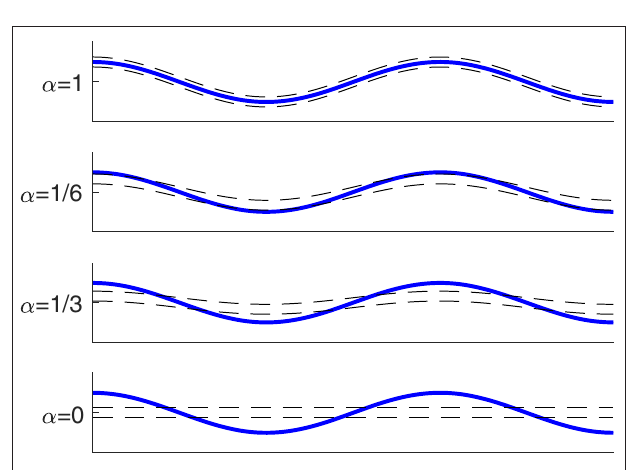
FIGURE 8 | Schematic showing the virtual net sampling volume δ over a wave for different α values as described by Equation (21). The net sampling volume is denoted by the area between the two black dashed lines, and the free surface is shown with the solid blue line. In this case, δ/ A wave-averaged sampled volume is constant for all α